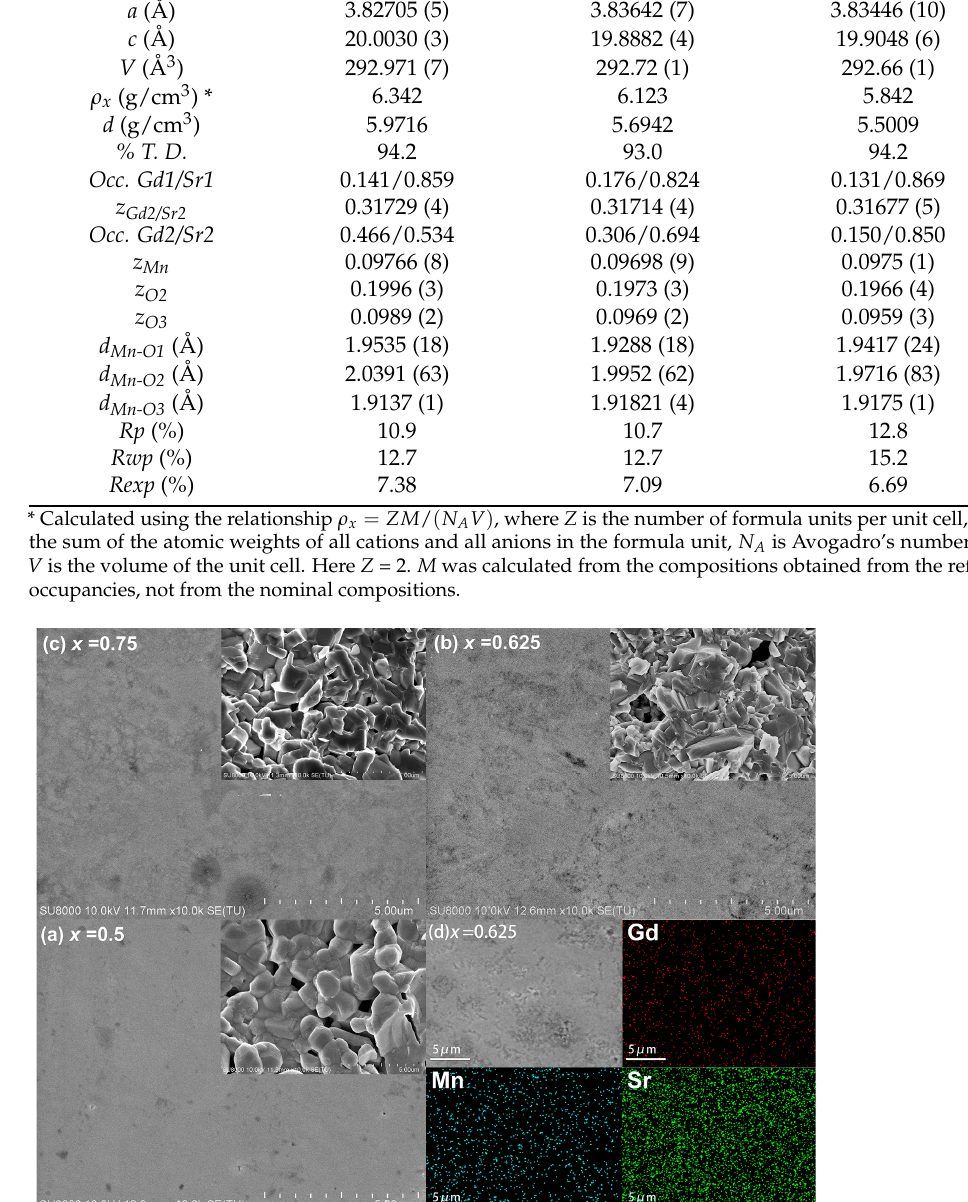
Table 1. Structural parameters obtained from Rietveld re fi nements for Gd 2 − 2 x Sr 1+2 x Mn 2 O 7 . Space group I4/mmm (No. 139), atomic Wycko ff positions: Gd1/Sr1, 2 b (0, 0, 1/2), Gd2/Sr2, 4 e (0, 0, z ), Mn, 4 e (0, 0, z ), O1, 2 a (0, 0, 0), O2, 4 e (0, 0, z ), O3, 8g (0, 1/2, z ). x = 0.5